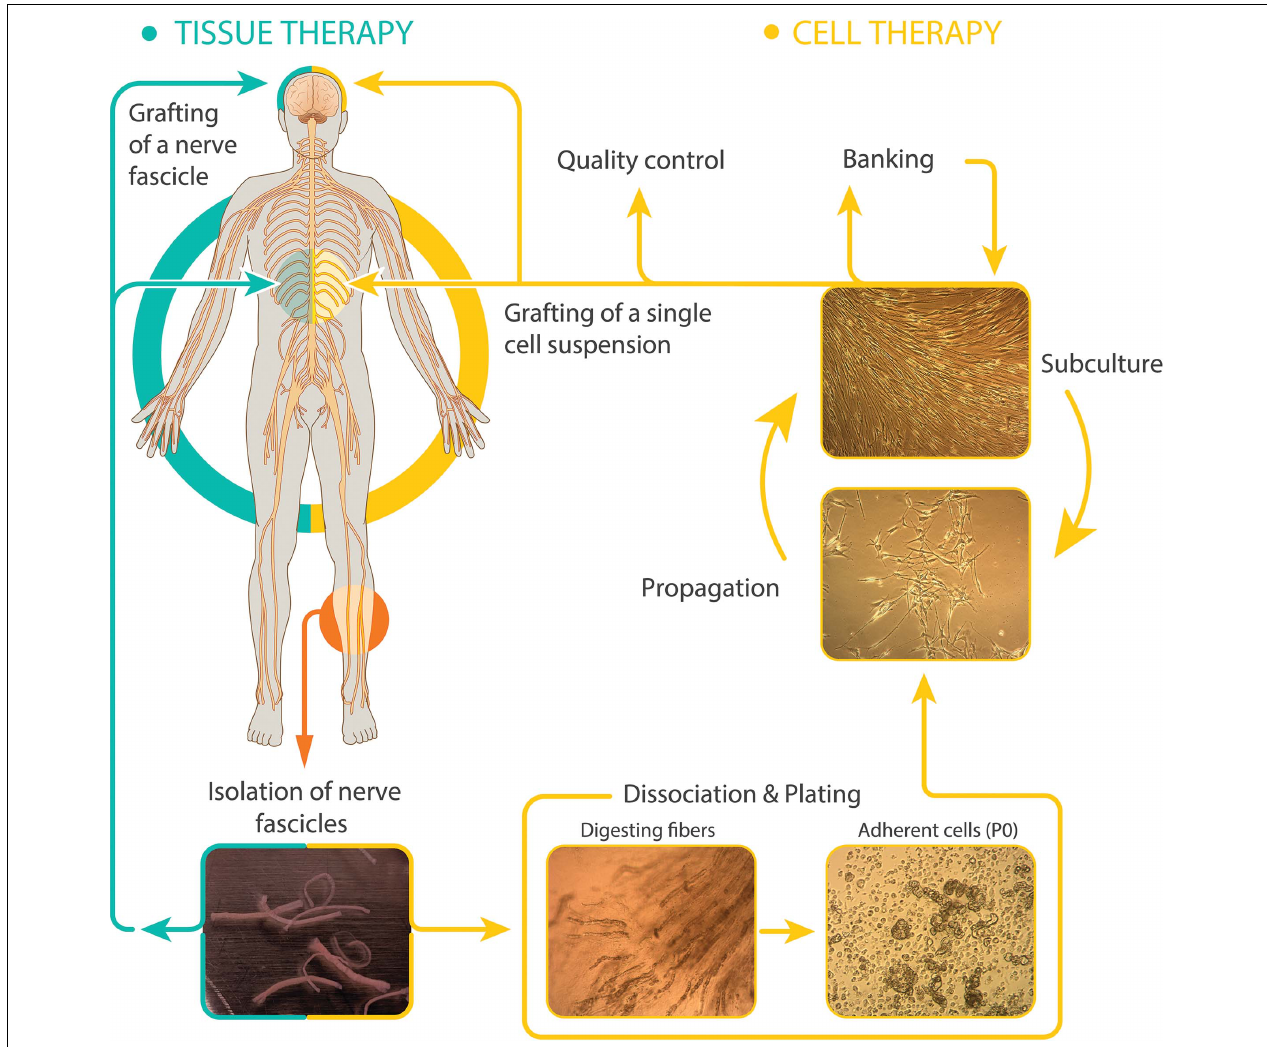
FIGURE 1 | Modalities of hSC-based autotransplantation therapies for neuroprotection and regeneration in the CNS. Most clinical initiatives in SCI and other paradigms have used autologous cultured (right, cell therapy) or uncultured (left, tissue therapy) hSCs from sural nerve delivered within or around the injury area (diagram). The established hSCs are usually purified and expanded before collecting them as a single cell suspension for implantation. Delayed dissociation of pre-degenerated (cultured) nerve fibers induces SC activation and enhances recovery of cells at passage-zero (P0). Representative images of dissected sural nerve fascicles in culture medium (bottom left) and intermediate steps in the isolation and culturing of hSCs are shown. Culture is usually carried out up to passage-2 to generate hSCs ready to transplant and stocks for banking. Digested fibers: nerve fascicles during enzymatic dissociation. Adherent cells: primary cells right after isolation showing abundant myelin debris. Propagation (with mitogenic factors) and subculture: purified hSCs at low (lower image, subconfluent cells) and high density (upper image, confluent